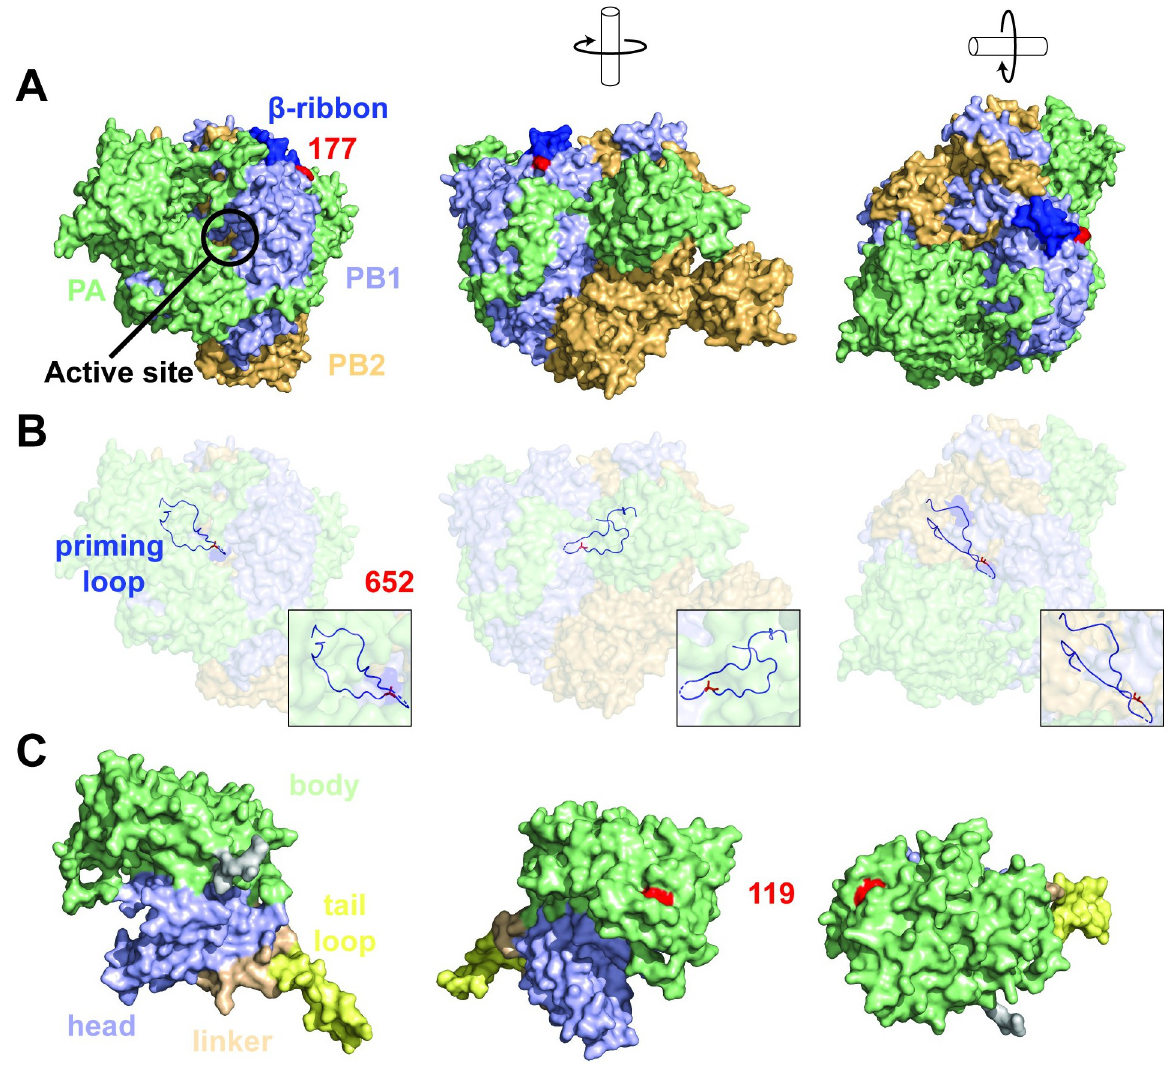
Fig 1. Location of PB1 E177G and A652T on the polymerase complex and I119M on the nucleoprotein. A, overview of the polymerase subdomains with PB1 (light-blue), PB2 (paleyellow), and PA (pale-green) in different orientations and the location of PB1 residue 177 (red). B, location of PB1 residue 652 (red) showing individual atoms within the priming loop (light-blue) on a transparent polymerase background. C, overview of the nucleoprotein subdomains with head (light-blue), tail loop (yellow), linker (pale-orange) and body (pale-green) in different orientations and the location of NP residue 119